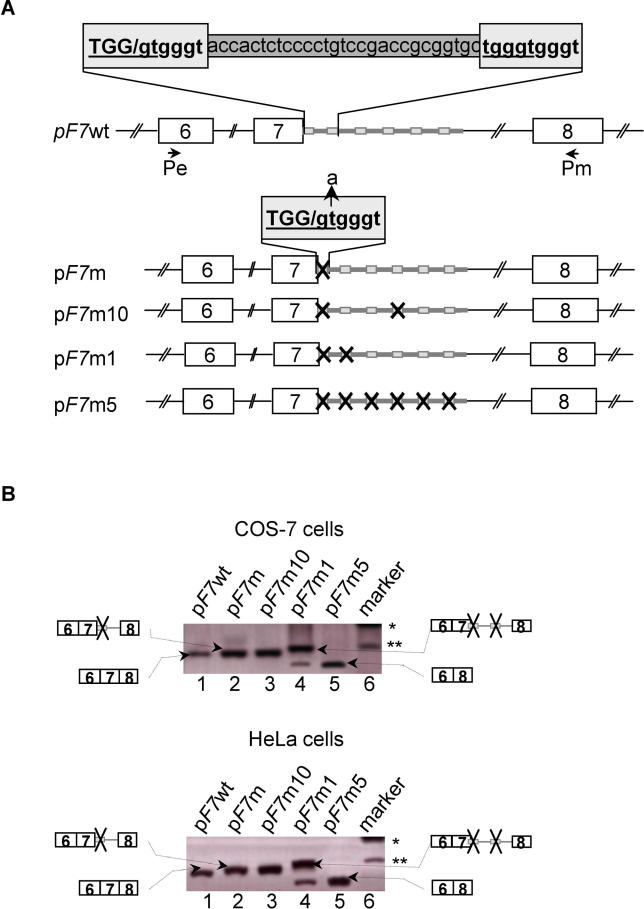
The Identified Scanning Mechanism for Splice Site Selection Is Not Cell Type–Dependent(A) Schematic representation of the constructs used in this experiment (see legend to Figure 2A for the meaning of each symbol).(B) RT-PCR amplification of F7 transcripts isolated from COS-7 and HeLa cells transfected with the above-mentioned constructs. The products corresponding to the different PCR fragments, as identified by sequencing, are schematically represented on both sides of the figure.